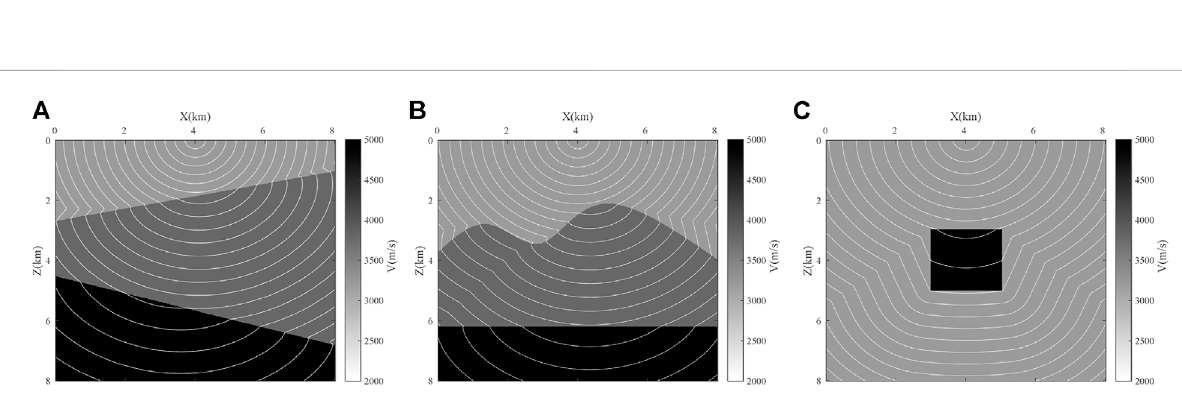
traversing the selected group G within a narrow band, so the GMM time complexity is O(N) , so GMM The computational ef fi ciency is higher than FMM, but when FIM expands the active list, it incorporates all the neighboring points of the calculation points into the calculation, and updates all the nodes in the active list, so this is also the root cause of the calculation ef fi ciency of the FIM algorithm being higher than the above two algorithms and as the computational model increases, This advantage will be even more pronounced.